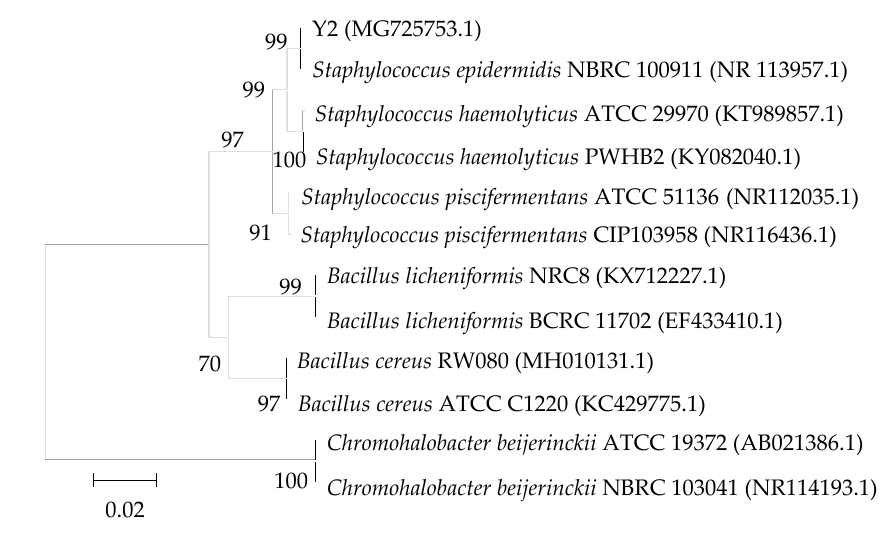
Figure 1. Phylogenetic tree of S. epidermidis Y2 based on the sequence alignment.